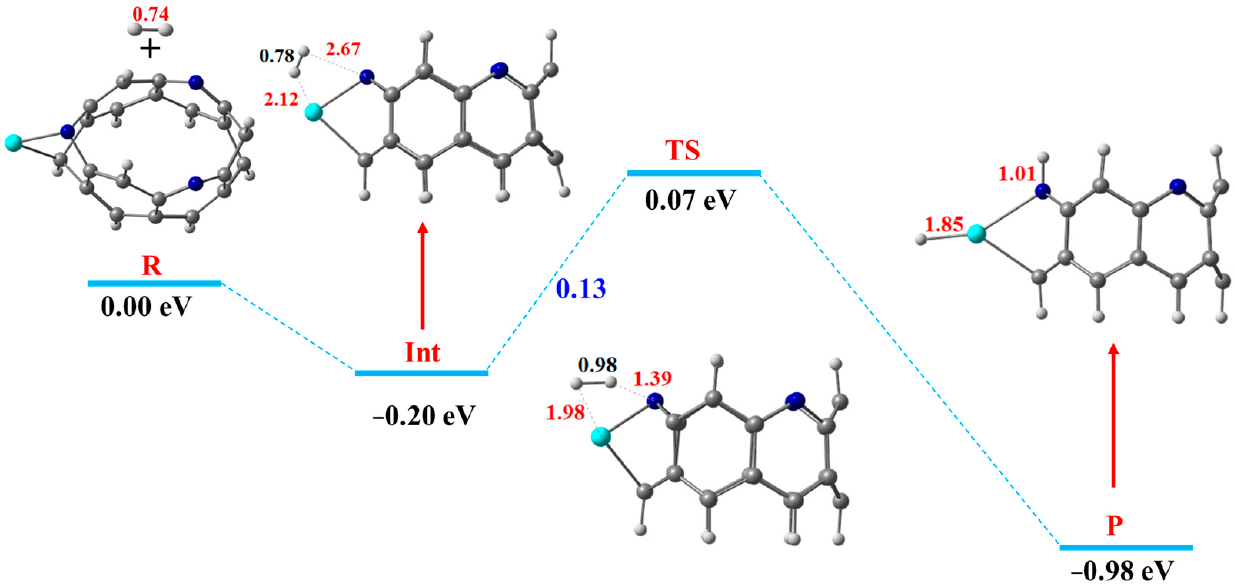
Figure 6. The free energy diagram of the HDR mechanism over the Sc@NB catalyst, where the reactant, intermediate, transition state, and product are demonstrated as R, Int, TS, and P (H, light grey; C, grey; Sc, cyan blue; N, blue).